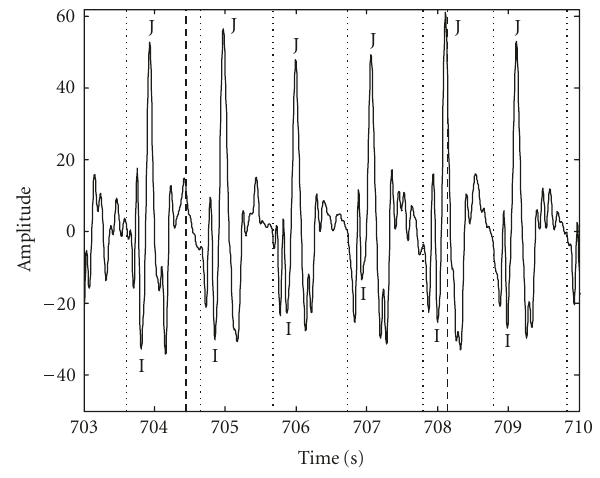
Figure 1: The heart-originated BCG signal during one respiratory cycle [4]. The “I” and “J” spikes are marked with circles. The dot- ted lines point the “R” spikes detected from the ECG signal, and the dashed lines point the beginning and the end of the respiratory cycle.